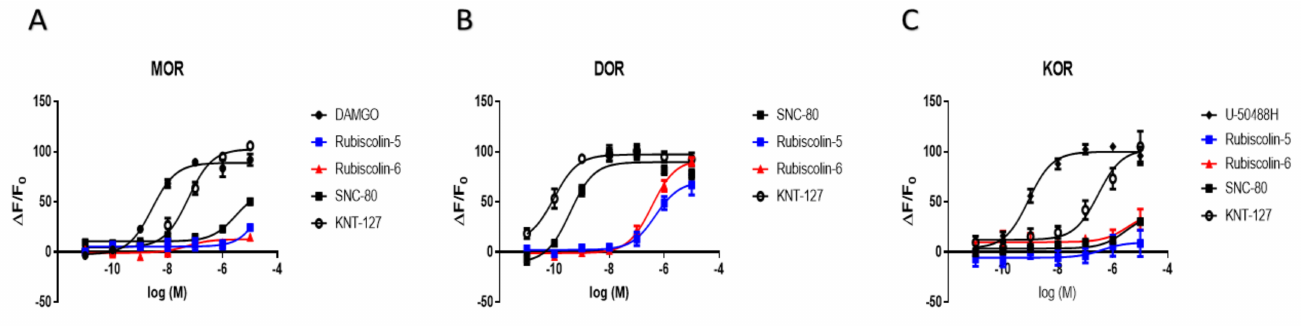
Figure 4. Changes in intracellular cAMP levels induced by rubiscolin-5, rubiscolin-6, and opioid compounds. Cells expressing MOR ( A ), DOR ( B ), or KOR ( C ) were treated with the listed compounds (10 − 11 –10 − 5 M), and intracellular cAMP levels were measured with the cADDis ® cAMP assay. Concentration–response curves were prepared by calculating cAMP levels relative to the data obtained with 10 − 5 M DAMGO for MOR ( A ), 10 − 5 M SNC-80 for DOR ( B ), and 10 − 5 M U-50488H for KOR ( C ). Data are presented as means ± S.E.M. for three independent experiments ( n =